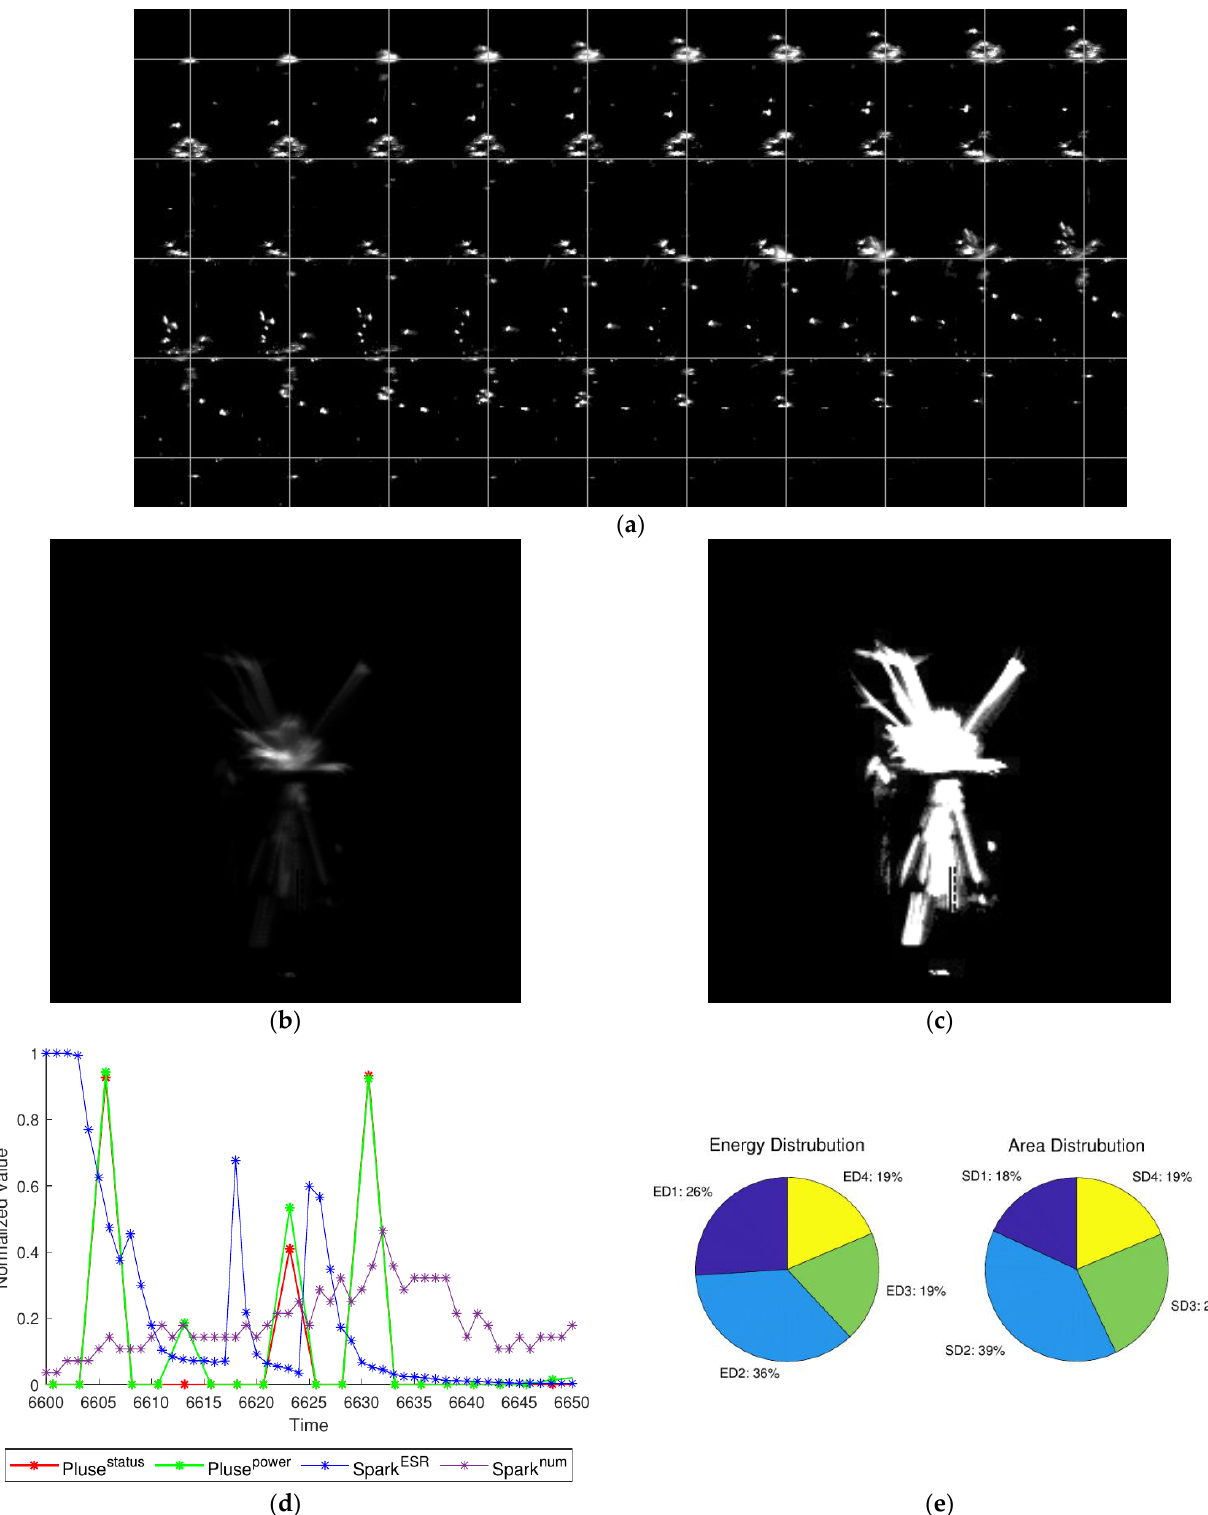
Figure 14. Single spark process (under the condition of trial 1): ( a ) image time series of machining process (50 frames); ( b , c ) combine image with normalization or binarization; ( d ) pulse waveform and spark features; ( e ) energy and area distribution.